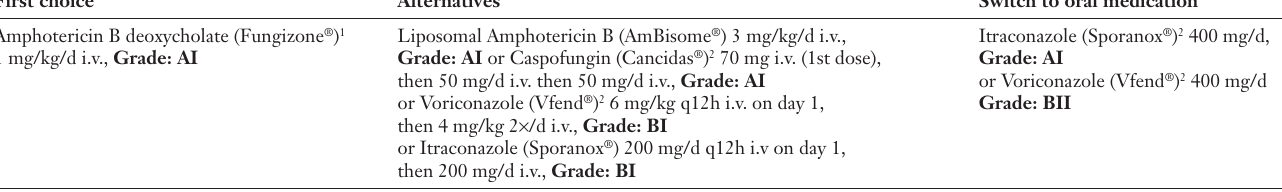
Empirical antifungal therapy in patients with neutropenia and persistent